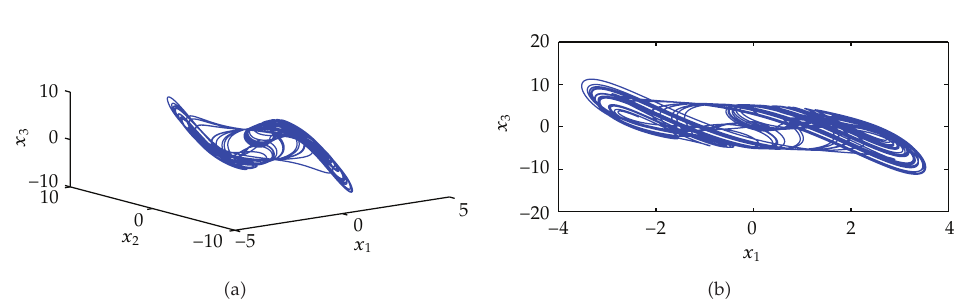
Figure 5: Chaotic attractors of the fractional-order Arneodo chaotic system (cid:2) 3.7 (cid:3) for q d (cid:8) 0 .